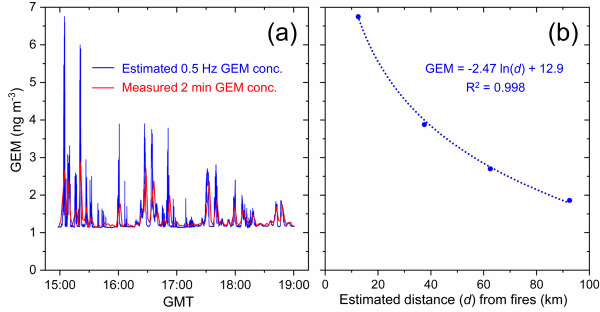
Figure 4. (a) 2min measured and 2s calculated GEM concentra- tion; the latter was calculated by conversion of the 0.5Hz CO data using the GEM : CO emissions ratio (ER) measured in the GLP fires. (b) The maximum 2s calculated GEM concentration derived from GEM : CO ER for each screen and the estimated distance this measurement was from the GLP